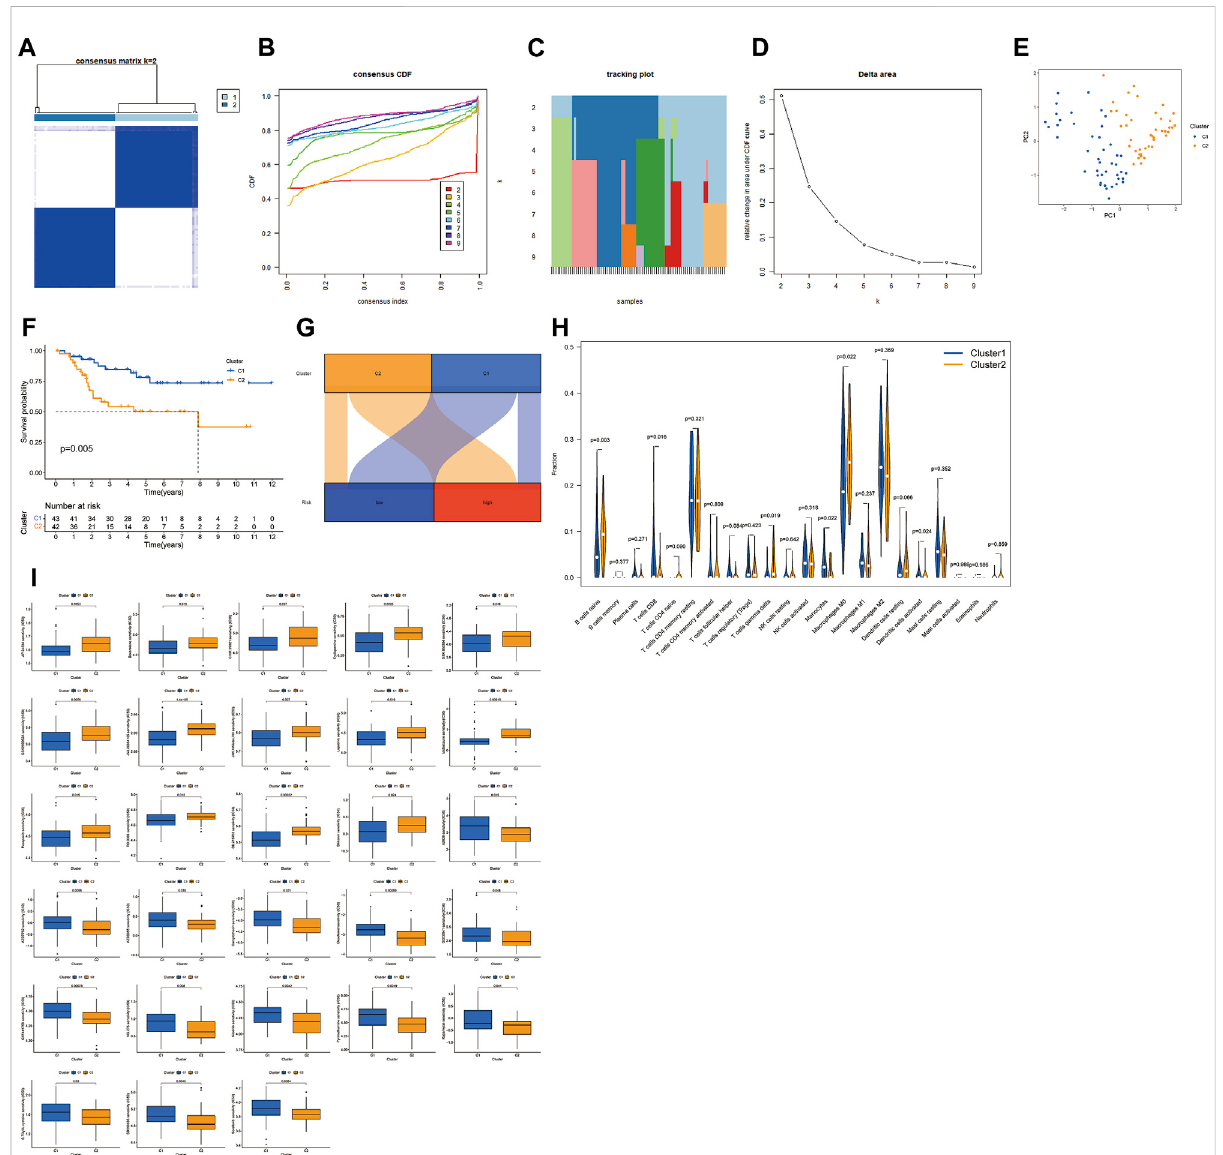
Consensus clustering of two MRmetabolism. (A) Consensus clustering matrix for k = 2. (B) Consensus clustering CDF with k = 2 – 9. (C) The tracking plot for different k. (D) The area under the CDF curve for different k. (E) PCA of OS samples according to the clustering. (F) The survival estimates of the two clusters. (G) The Sankey diagram of the two risk groups and the two clusters. (H) The differential in fi ltration of tumour immune cells in the two clusters. (I) The difference of sensitivity of drugs in the two